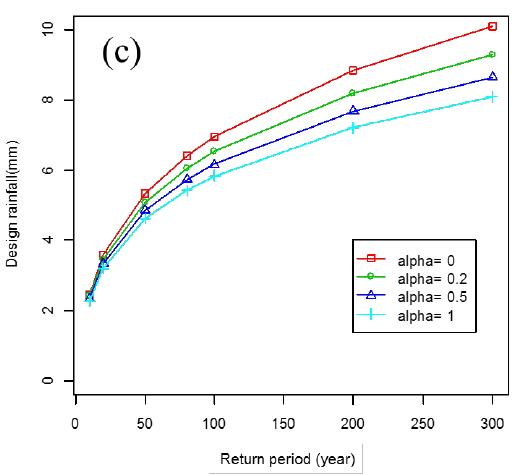
Figure 9. ( a ) GEV (0, 1, 0.1) with no outlier; ( b ) replacing the maximum with an outlier of 8; and ( c ) with an outlier of 10.